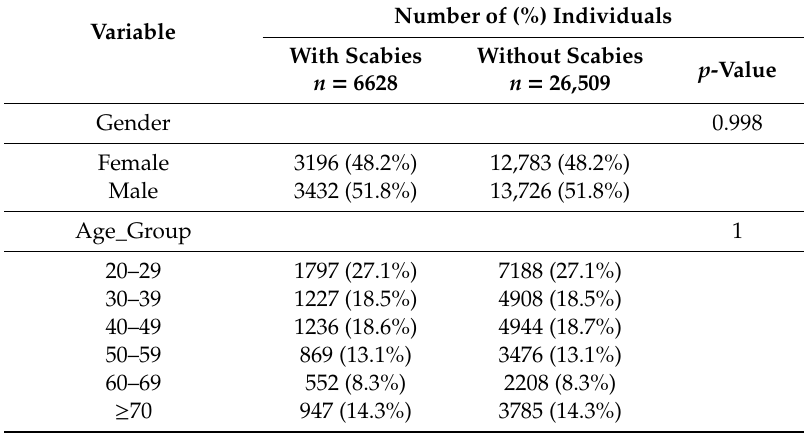
Table 1. Age group, gender, and comorbidity distributions of the scabies group and control group